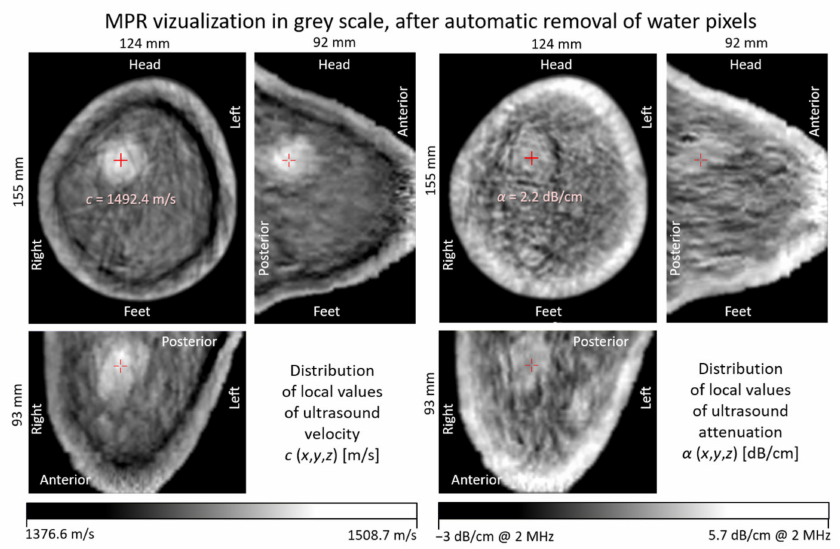
Figure 20. In vivo imaging results of the left breast of a 66-year-old woman (Patient 2) with the nipple sinker application, at 25 ◦ C water temperature using a prototype of the USB hybrid